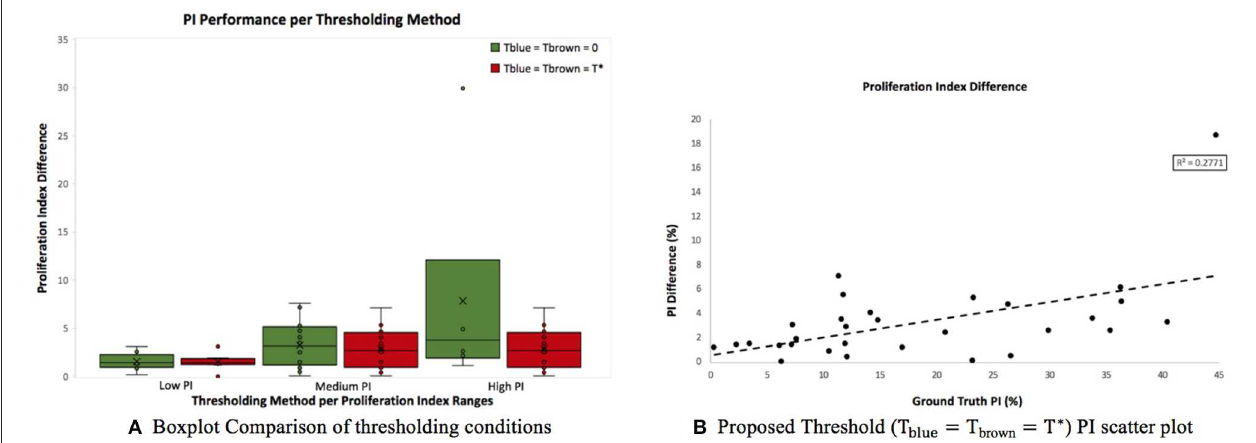
FIGURE 9 | (A) Boxplot comparing PI difference performance between thresholds for low ( < 10%), intermediate (10–30%), and high ( > 30%) PI levels. (B) Correlation between PI difference and manual PI estimates for the balanced histogram approach and automated radii calculator.